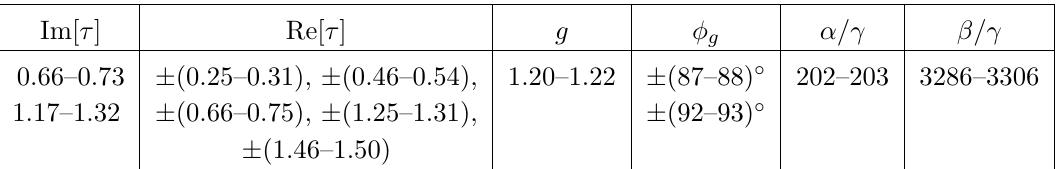
Table 4 . The parameter regions consistent with the experimental data of table 3 for model I(a). Results do not change under the exchange of (cid:11)=(cid:13) and (cid:12)=(cid:13)